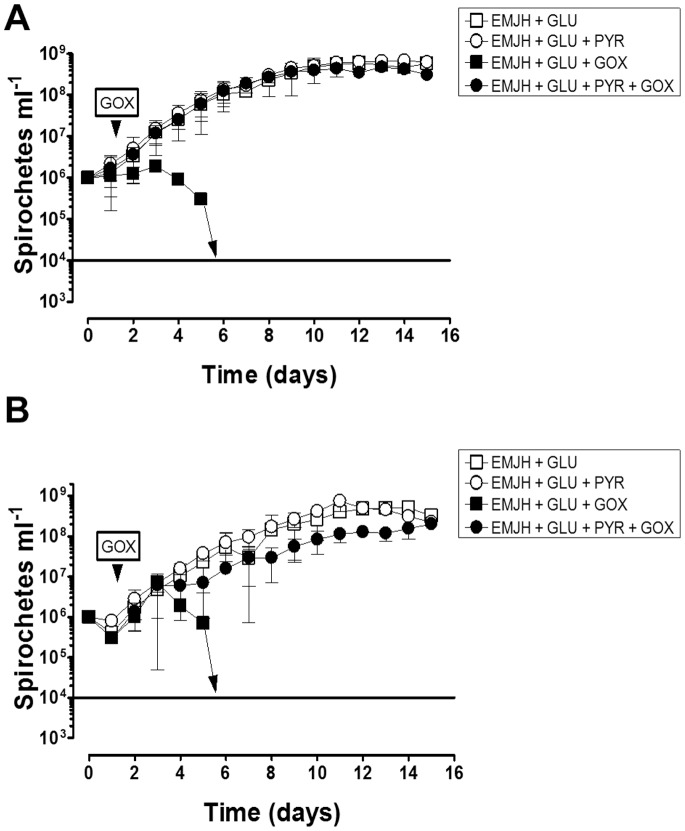
Pyruvate Protects Pathogenic Strains of Leptospira interrogans Against H2O2.(A) L. interrogans serovar Manilae L495 was challenged with GOX (0.32 mU ml−1) in EMJH medium with and without added pyruvate (PYR). Stationary phase cultures were diluted to 106 cells ml−1 in EMJH medium with glucose (2 g L−1) and with or without PYR (910 µM). After 1.5 days of growth, GOX was added, indicated by the arrowhead and growth was monitored by direct counting of spirochetes by dark field microscopy. The limit of detection (LOD) for direct counting is indicated by a solid line and cultures with spirochetes below the LOD are indicated by the arrow pointing to the line, which corresponds to ≈104 spirochetes ml−1. (B) L. interrogans serovar Lai 56601 was challenged with GOX as described above. Results in (A) and (B) show the mean ±1 SD from three separate experiments performed in duplicate or triplicate.